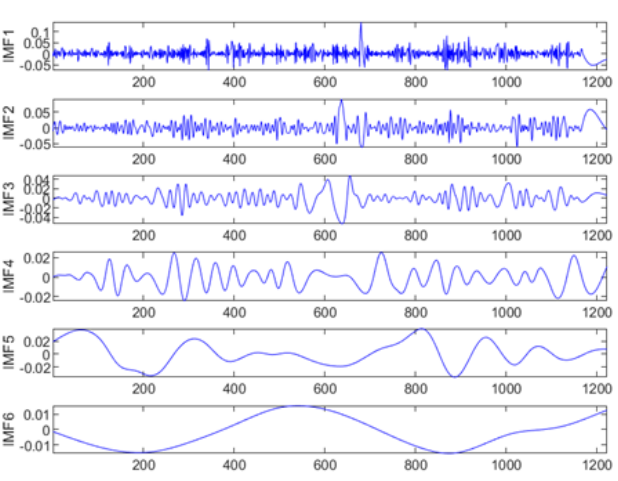
Figure 8. Top 6 IMF components.